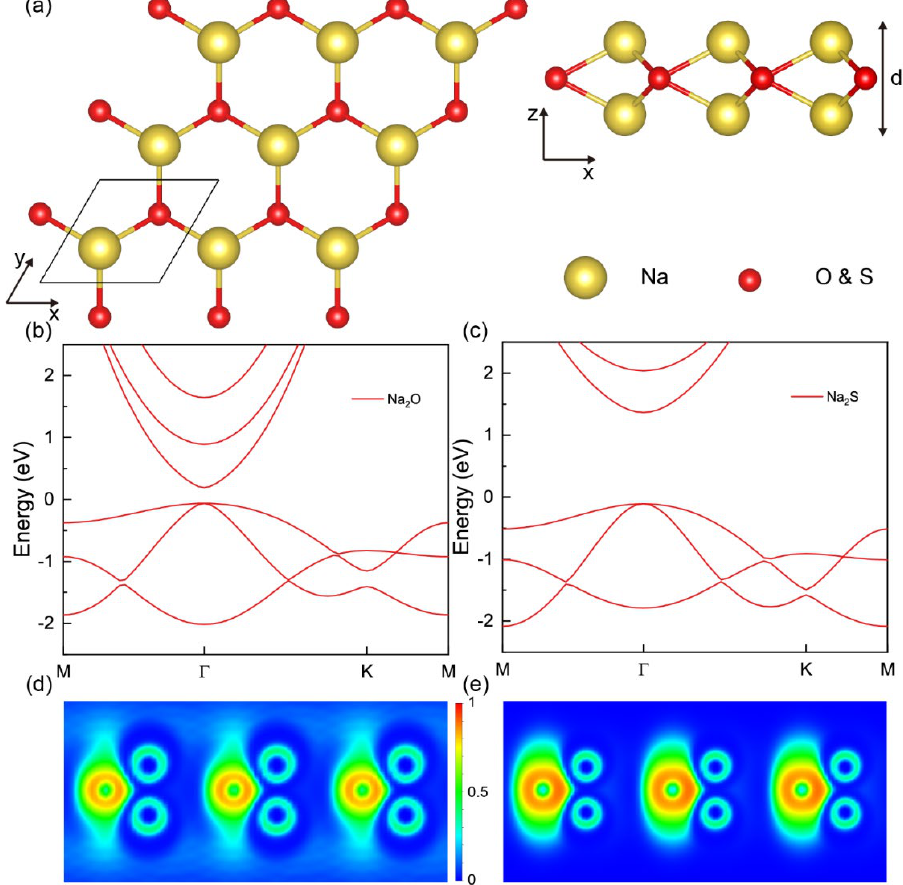
Figure 1. ( a ) Top and side views of Na 2 X (X = O and S) monolayers. The electronic band structures of ( b ) Na 2 O and ( c ) Na 2 S monolayers. The normalized electron localization function for ( d ) Na 2 O and ( e ) Na 2 S monolayers.